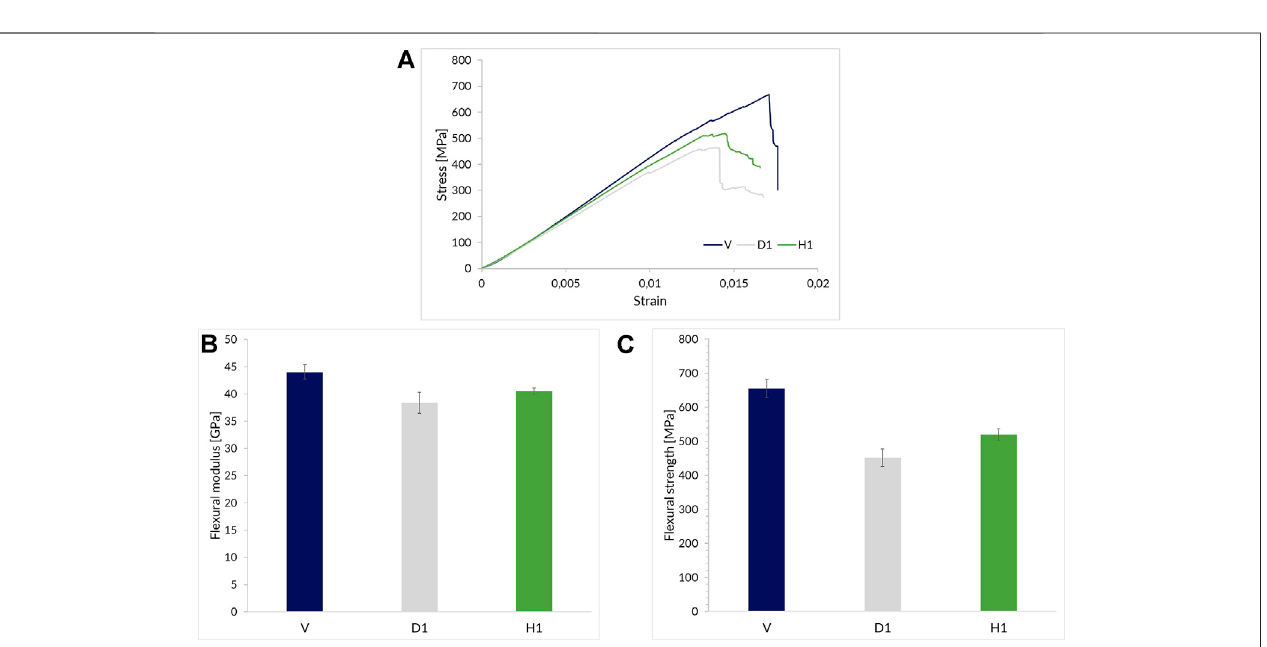
FIGURE 2 | (A) Examples of 3-point bending test curves for [(0/90)] 18 V, D1, and H1 samples, and (B) the fl exural modulus and (C) the fl exural strength for V, D1, and H1